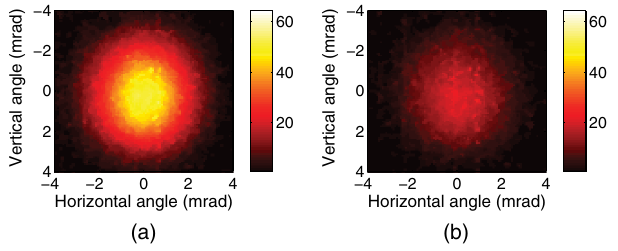
FIG. 2. Averaged far-field images of spontaneous undulator radiation for (a) R 56 ¼ 0 . 1 mm and (b) R 56 ¼ 2 . 2 mm when suppression is maximal. The color scale shows intensity (arbitrary units). Gun phase is at − 14 deg.